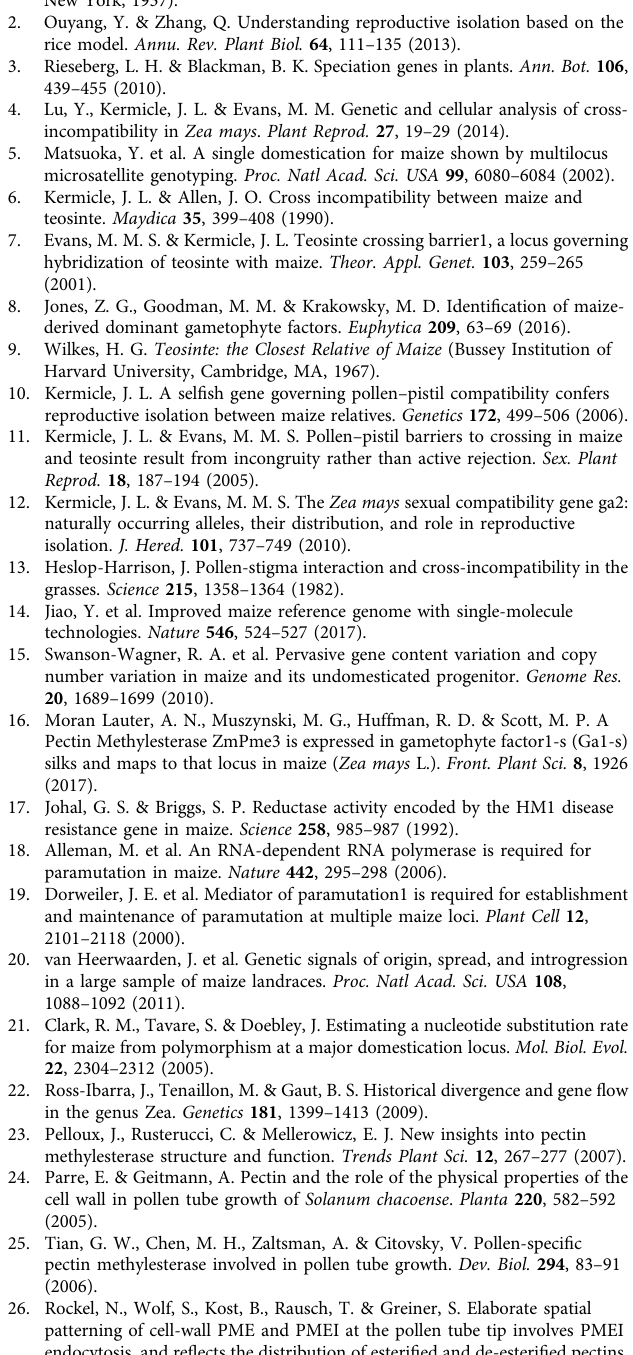
Silk tissue collection, RNA isolation, and cDNA synthesis . Plants for RNA isolation were grown in summer fi eld conditions in Stanford, CA. Silk tissues were